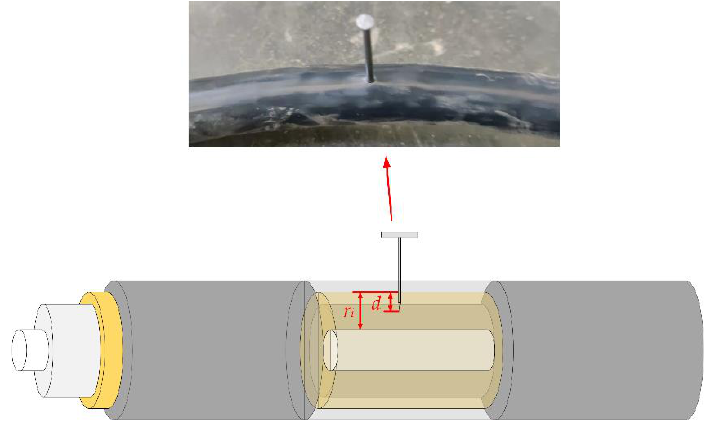
Figure 8. The cable sample inserted with a nail.